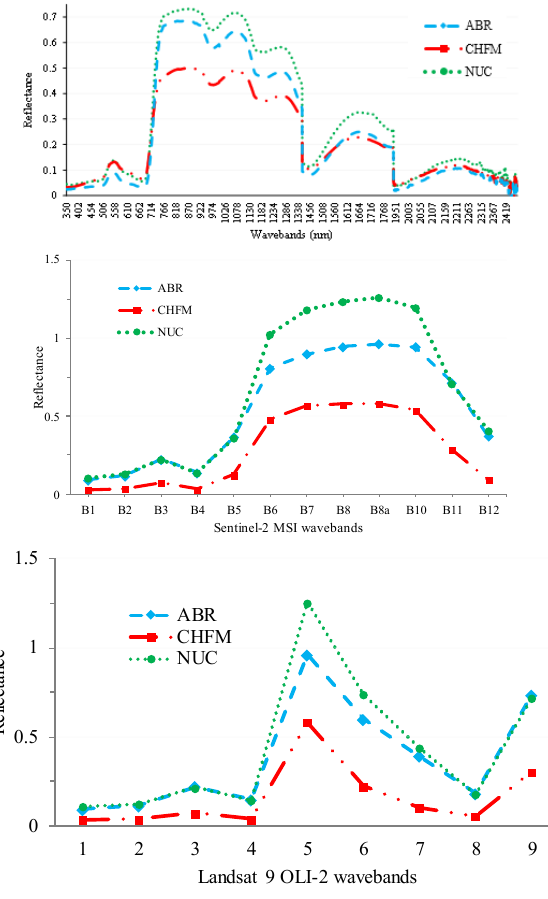
Figure 2: Mean spectral variability of tomatoes under ABR effluent, NUC and CHFM treatments.